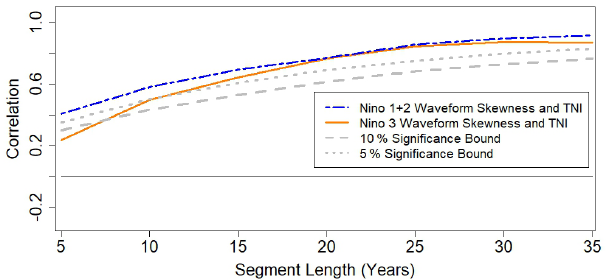
Figure 12. Correlation between waveform skewness and TNI mag- nitude.